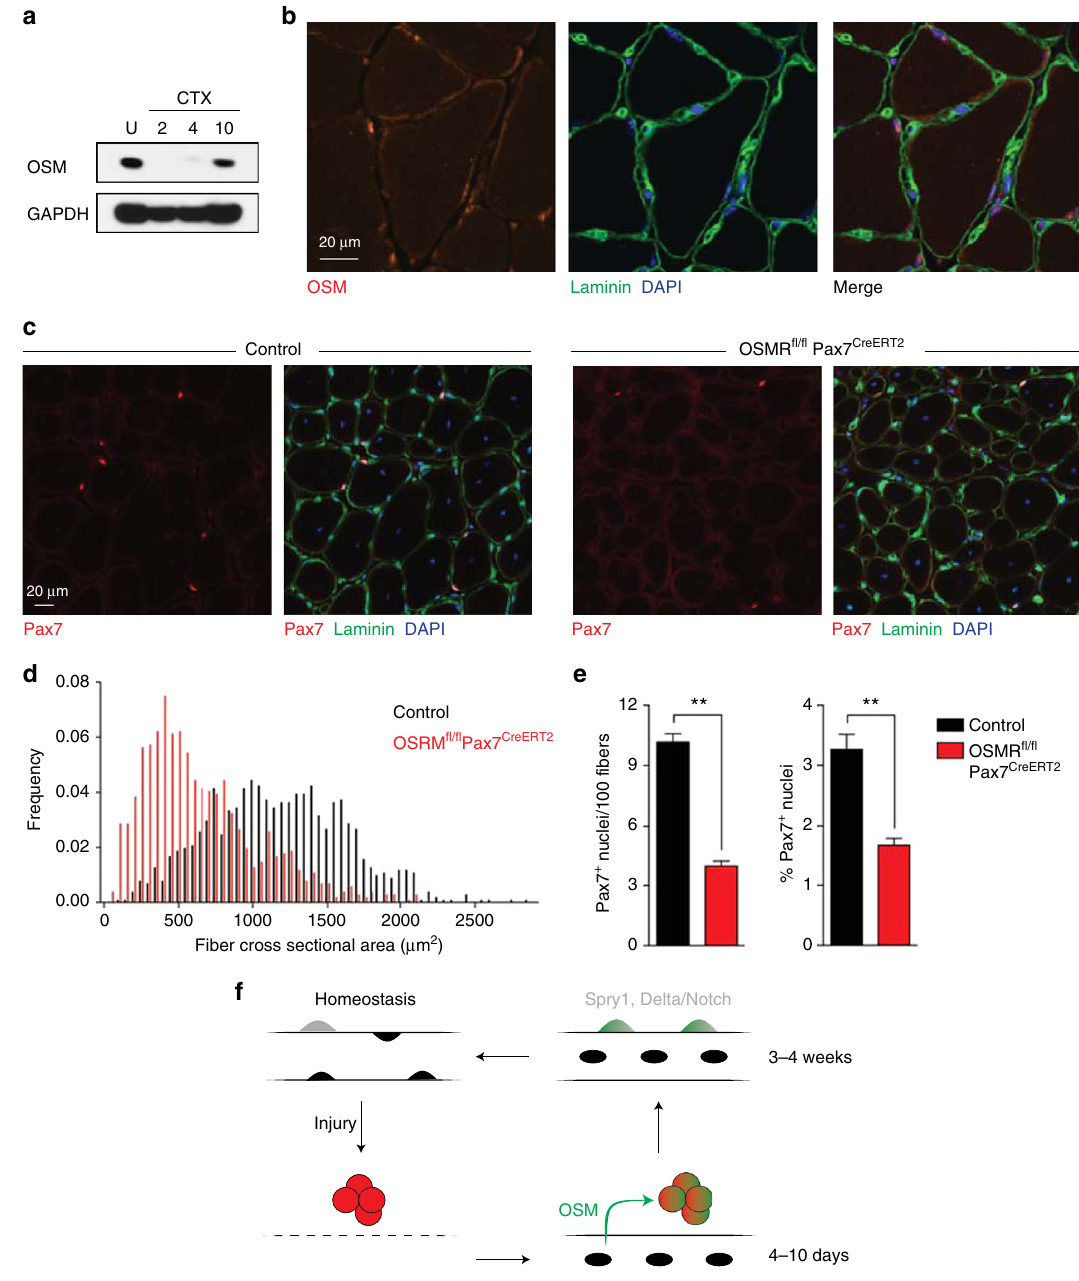
Fig. 4 OSM signaling regulates quiescence induction and is required for proper muscle regeneration. a Western blot of tibialis anterior muscle, either uninjured (U) or at the indicated days following cardiotoxin injury. b Immuno fl uorescence analysis of wild type uninjured TA muscle. Blue: DAPI; Green: Laminin; Red: OSM. Note the expected perinuclear staining pattern of OSM, consistent with synthesis and export through the known perimyonuclear ER/ Golgi network 49, 50 . c Representative immuno fl uorescence images from tibialis anterior muscle of control (Osmr fl / + ) or conditional knockout (Osmr fl / fl Pax7 CreERT2 ) animals following deletion and 2 rounds of cardiotoxin injury and regeneration. For each sample, single channel Pax7 staining is shown on the left and a merged 3 channel image is shown on the right. Blue: DAPI; Green: Laminin; Red: Pax7. d Cross-sectional area (CSA) distribution of myo fi bers from TA muscle of control (Osmr fl / + ) or conditional knockout (Osmr fl / fl Pax7 CreERT2 ) animals (3 8 – 12 week old animals each) following deletion and 2 rounds of cardiotoxin injury and regeneration. >1000 fi bers were quanti fi ed per genotype. e Quantitation of Pax7 + stem cells in serial sections from tibialis anterior muscle of control (-Cre, Osmr fl / + ) or conditional knockout ( + Cre, Osmr fl / fl Pax7 CreERT2 ) animals following deletion and 2 rounds of cardiotoxin injury and regeneration. Results are plotted as Pax7 + nuclei per 100 fi bers (left) or Pax7 + nuclei as a percentage of all visualized nuclei (right). f Model for OSM mediated quiesence induction during skeletal muscle regeneration. Under homeostatic conditions, stem cells (gray) are deeply quiescent but can become activated and proliferate (red) following injury. As regenerated myo fi bers begin to form, secretion of OSM (green) allows quiescence induction by actively promoting cell cycle exit within a subset of activated satellite cells while also maintaining stem cell identity. At later timepoints, 2 – 3 weeks following injury, upregulation of intrinsic regulators such as Sprouty1 matures the re-selected satellite cell pool back toward the deeply quiescent homeostatic